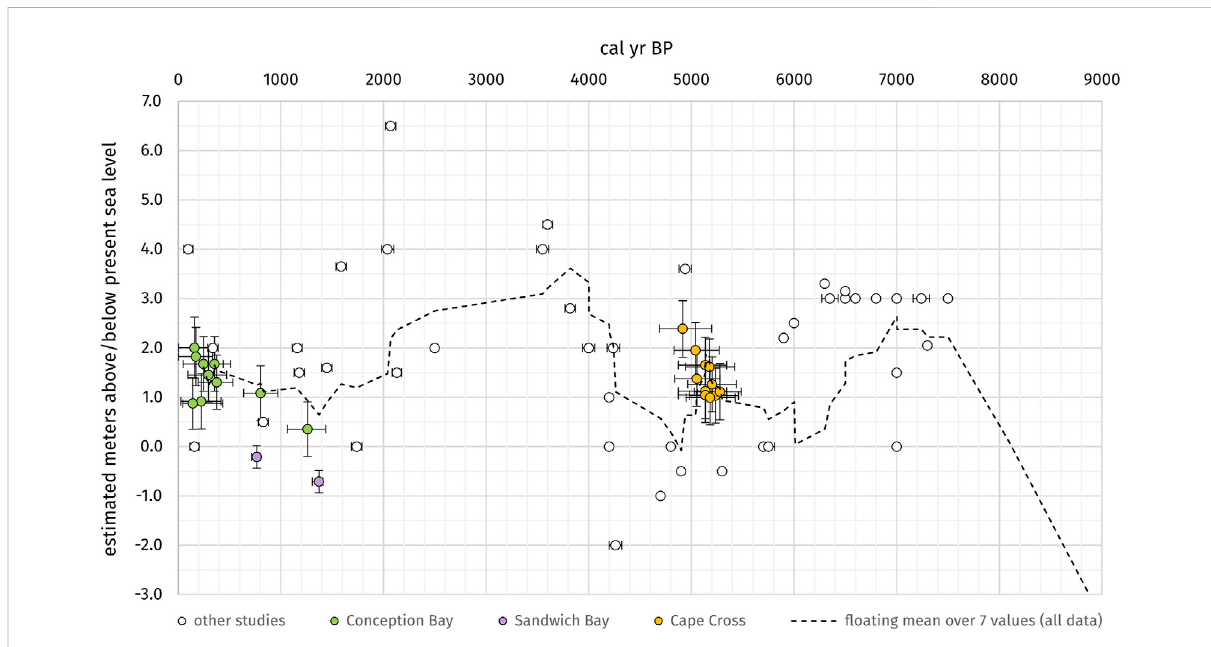
FIGURE 7 Sea-leveldatapointsfromthisstudyandotherstudies(whitecircles):ConceptionBay(green),SandwichBay/WalvisBay(violet)andCapeCross (orange). The black graph is the fl oating mean over 7 values of all shown datasets and approximately visualizes the estimated late to mid-Holocene sea-level fl uctuations along the southwestern African